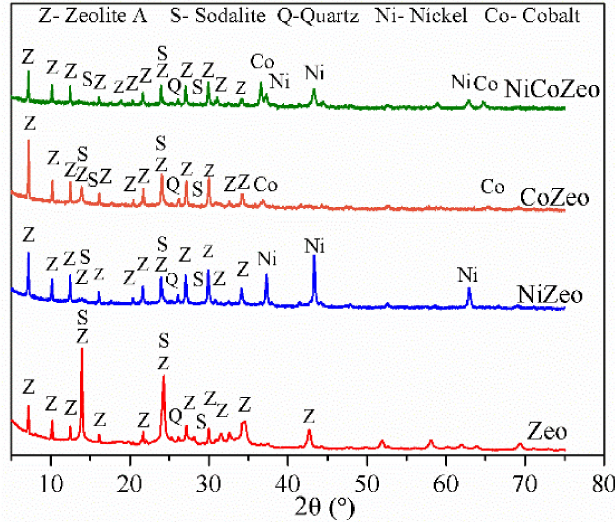
Figure 2. XDR of synthesized